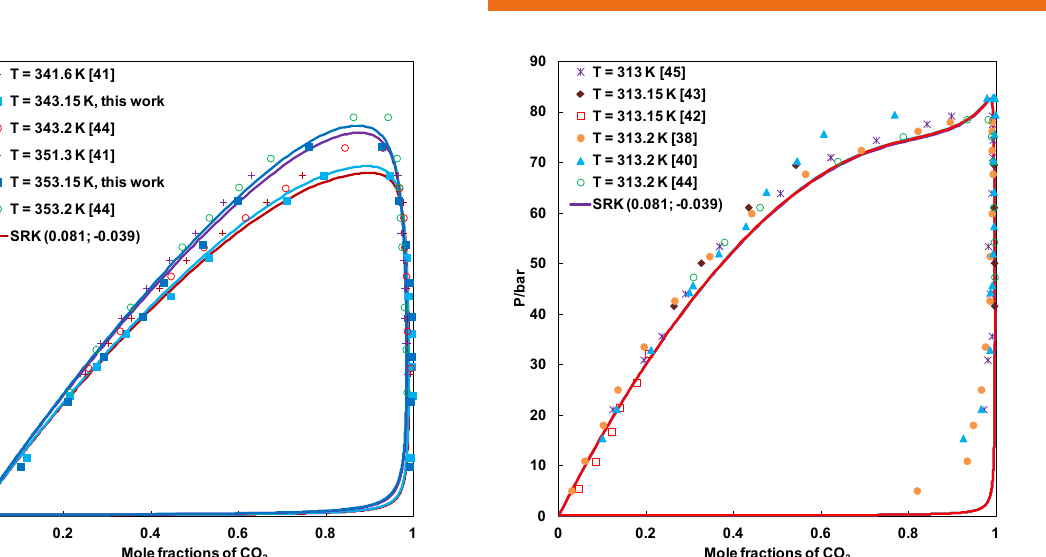
Figure 4. Comparison of literature data for the carbon dioxide + 2-methyl-1-propanol (isobutanol) system and calculations by SRK model: symbols, literature data at different temperatures; solid lines, predictions by SRK ( k = 0.081, l = -0.039). 12 12